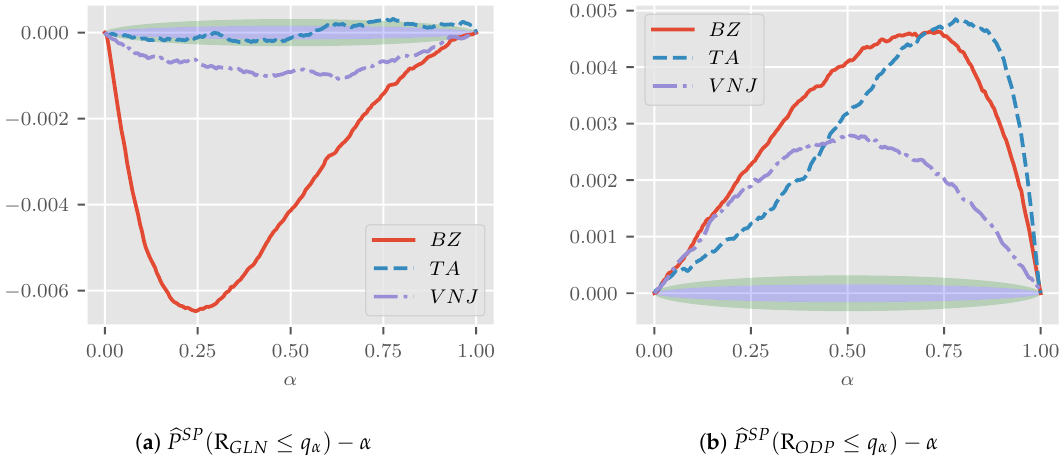
Figure 1. Approximation error of the first order saddle point approximation to R GLN , shown in ( a ), and R ODP , displayed in ( b ). Monte Carlo simulation with 10 7 draws taken as the truth. One and two Monte Carlo standard errors shaded in blue and green,